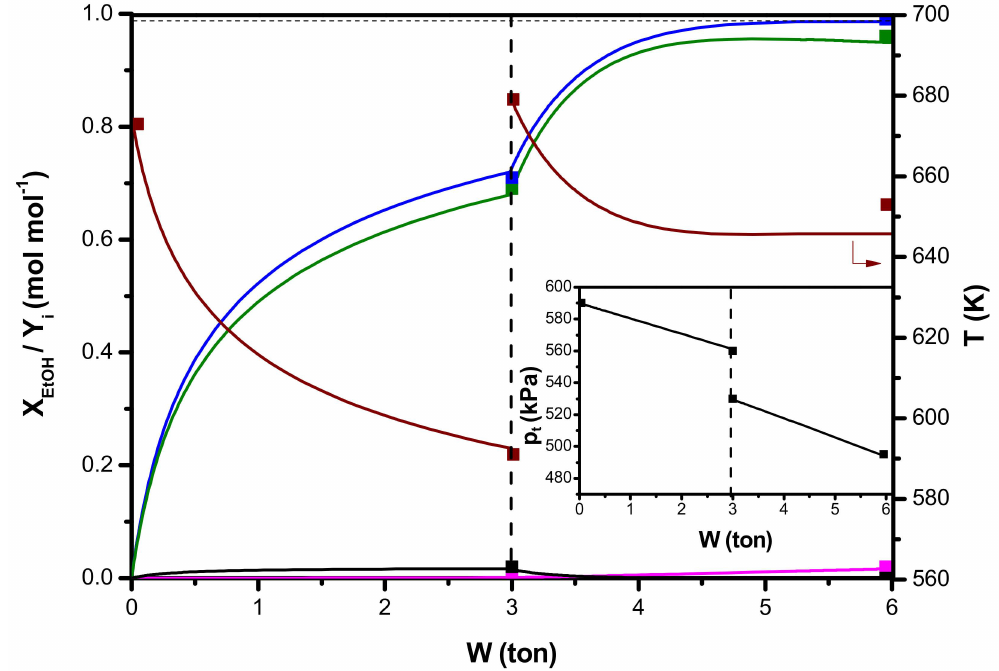
Figure 5. Ethanol conversion (X EtOH , blue), ethene, di-ethyl ether, and butene yield (green: Y C2H4 ; black : Y DEE ; magenta; Y C4H8 ), and temperature profiles (T) as a function of catalyst mass. The inset shows the pressure drop (p t ) as a function of catalyst mass. Calculations were made by integration of Equations (5)–(7) and (12) and simultaneously solving Equations (26) and (28) with the corresponding net production rates as defined in Equation (27), with parameters taken from Table 2 and the experimental conditions given in Table 3. Square symbols indicate the experimental points from [4] given in Table